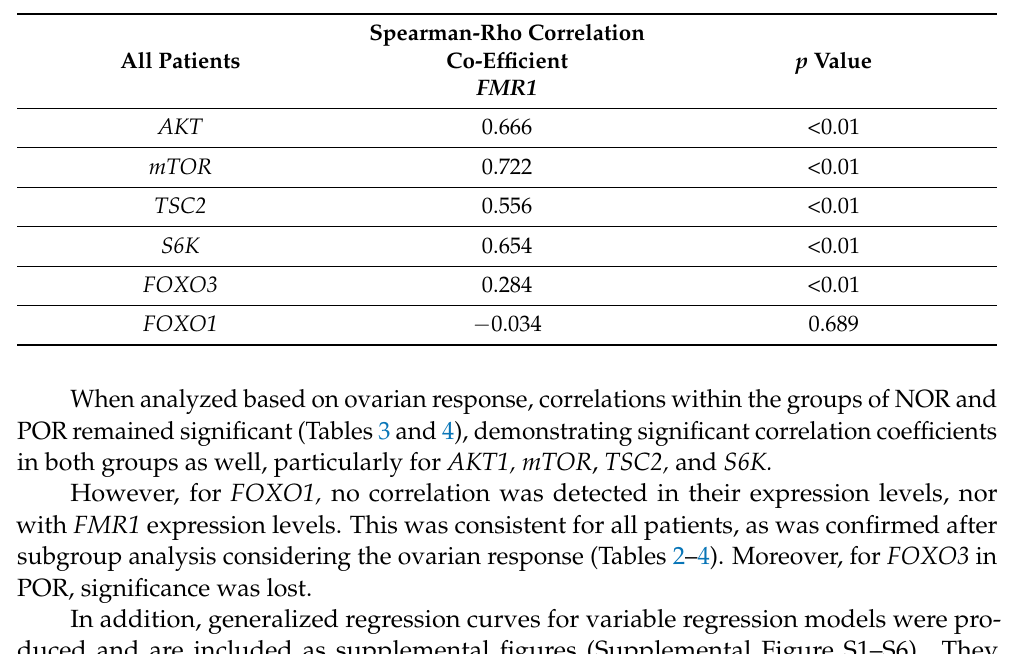
Table 2. Correlations of FMR1 gene expression and AKT1 (AKT serine/threonine kinase), FOXO3 (forkhead box O3), FOXO1 (forkhead box O1), mTOR (mechanistic Target of Rapamycin), TSC2 (tuberous sclerosis protein 2), and S6K (ribosomal protein S6 kinase) gene expression in all patients. The relative gene expression in granulosa cells of patients was normalized by two housekeeping genes and a granulosa cell calibrator using the ∆∆ Ct method. Correlation was calculated using the Spearman–Rho (r) correlation